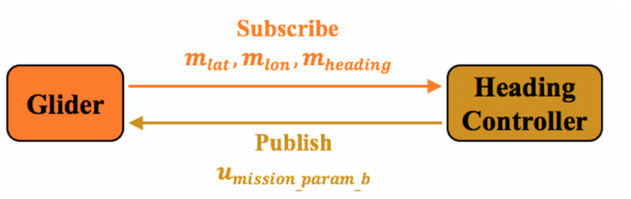
Figure 18. Exchange of data between the main vehicle control system and the heading controller when the glider changed its heading based on detection of a plume from a fluorometer measurement. Table 4. Control algorithm of the heading controller for backseat control when the glider changed its heading along the boundary of a simulated